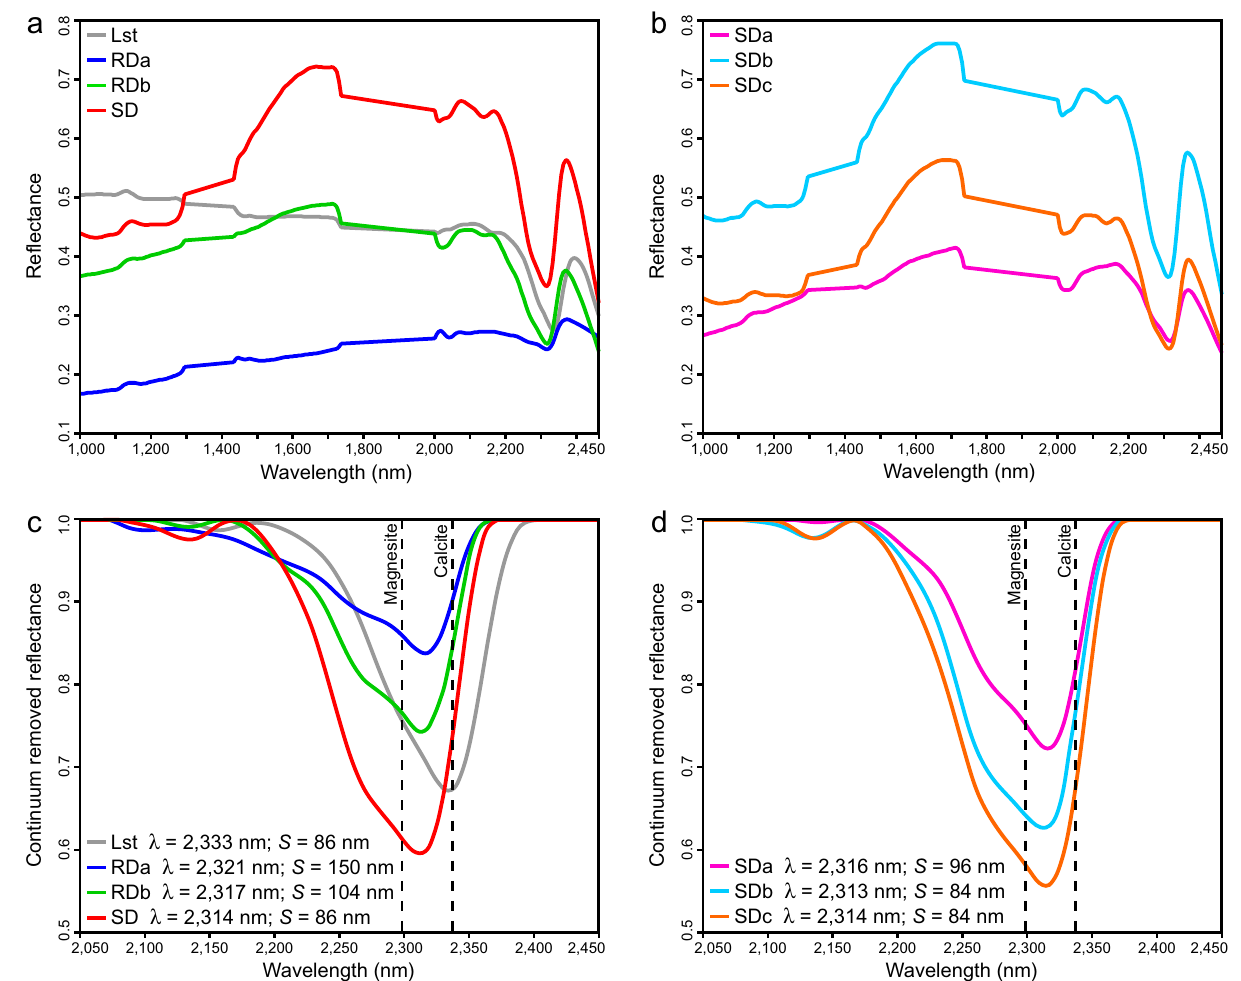
Figure 2. Reflectance spectra for ( a ) limestone (Lst), replacement dolomite a (RDa), replacement dolomite b (RDb), and saddle dolomite (SD). ( b ) Endmember SD consists of saddle dolomite a (SDa), saddle dolomite b (SDb), and saddle dolomite c (SDc). ( c ) Continuum removed reflectance for the ~ 2315 nm absorption-band showing Lst, RDa, RDb, and SD. ( d ) Continuum removed reflectance for the ~ 2315 nm absorption-band showing SDa, SDb, and SDc. Absorption-band positions (λ) were calculated using the linear interpolation method of van der Meer (his Fig. 2) 19 . Absorption-band asymmetry ( S ) is calculated as A–B, where A is the width from the short-wavelength shoulder to the absorption-band position and B is the width from absorption- band position to the long-wavelength shoulder 19